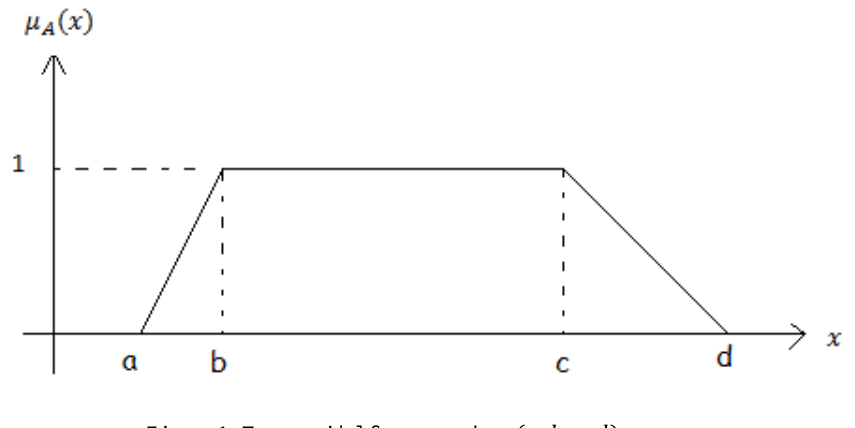
Figure 1. Trapezoidal fuzzy number (𝑎, 𝑏, 𝑐,